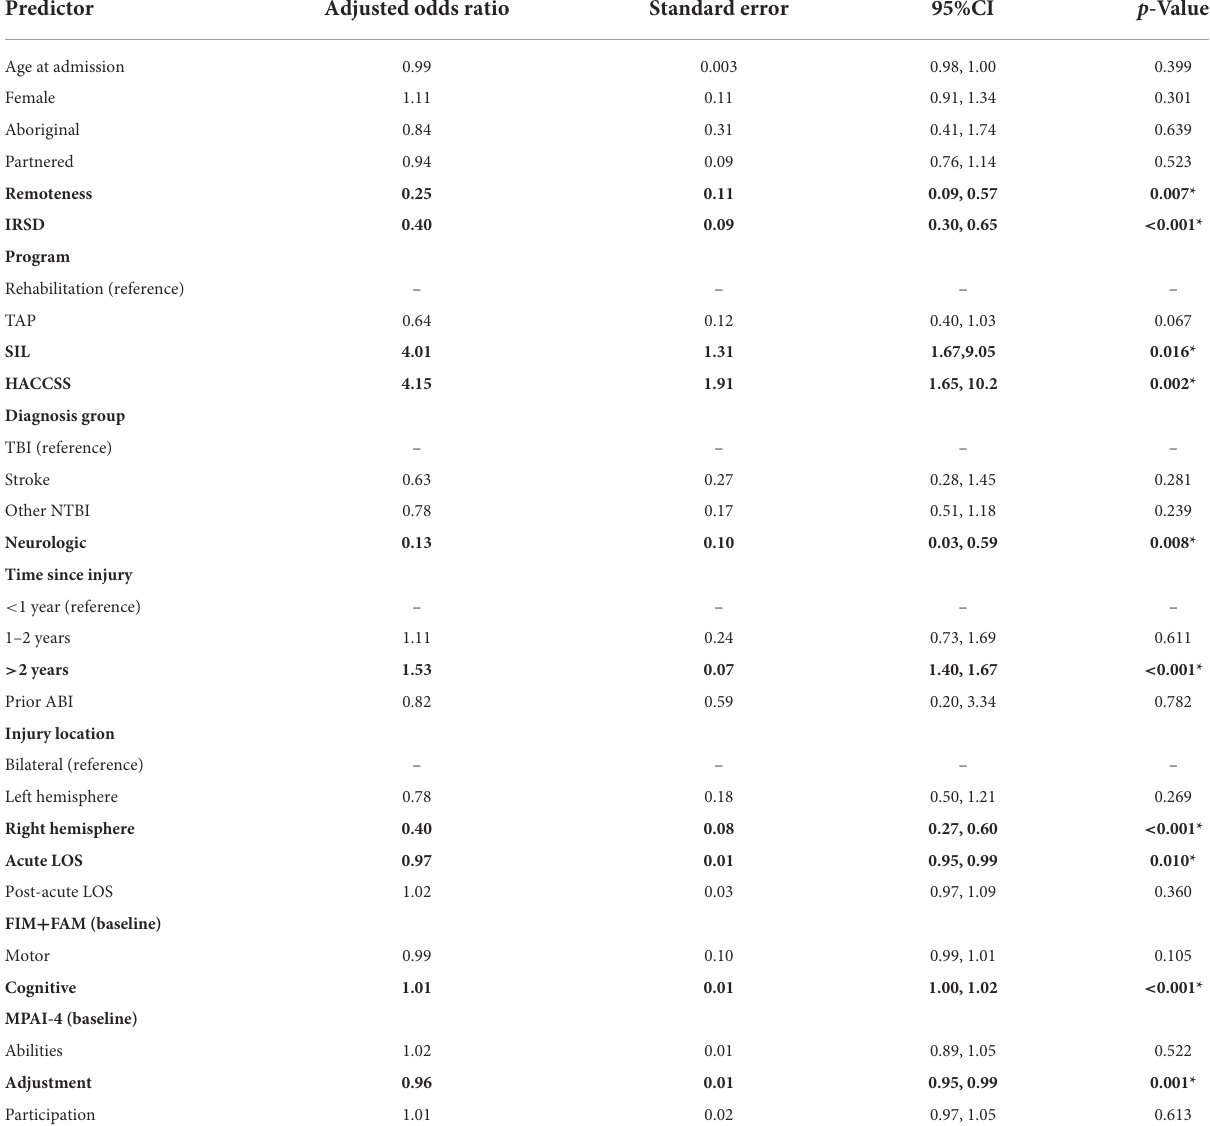
transitionalaccommodationprogram;TBI,traumaticbraininjury.Boldvaluesindicatestatisticalsignificanceatthe p <